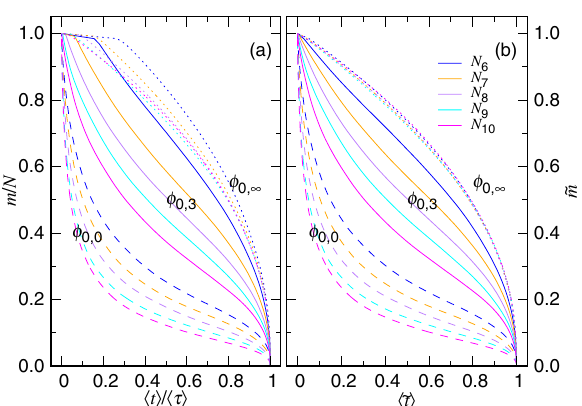
〈 t 〉 / 〈τ〉 / τ m vs. t t Figure 9. ( a ) m / N vs. and ( b ) at the three initial volume fractions: φ 0,0 �˜ ˜ (cid:31) (cid:30) (cid:31) (cid:30) � φ 0,3 0.3 2 − 3 (in solid line), and φ 0, 0.0 (in dotted line). The chain length can be read in the legend of ≡ × ∞ ≡ 2 i Panel ( b ) where N i ≡